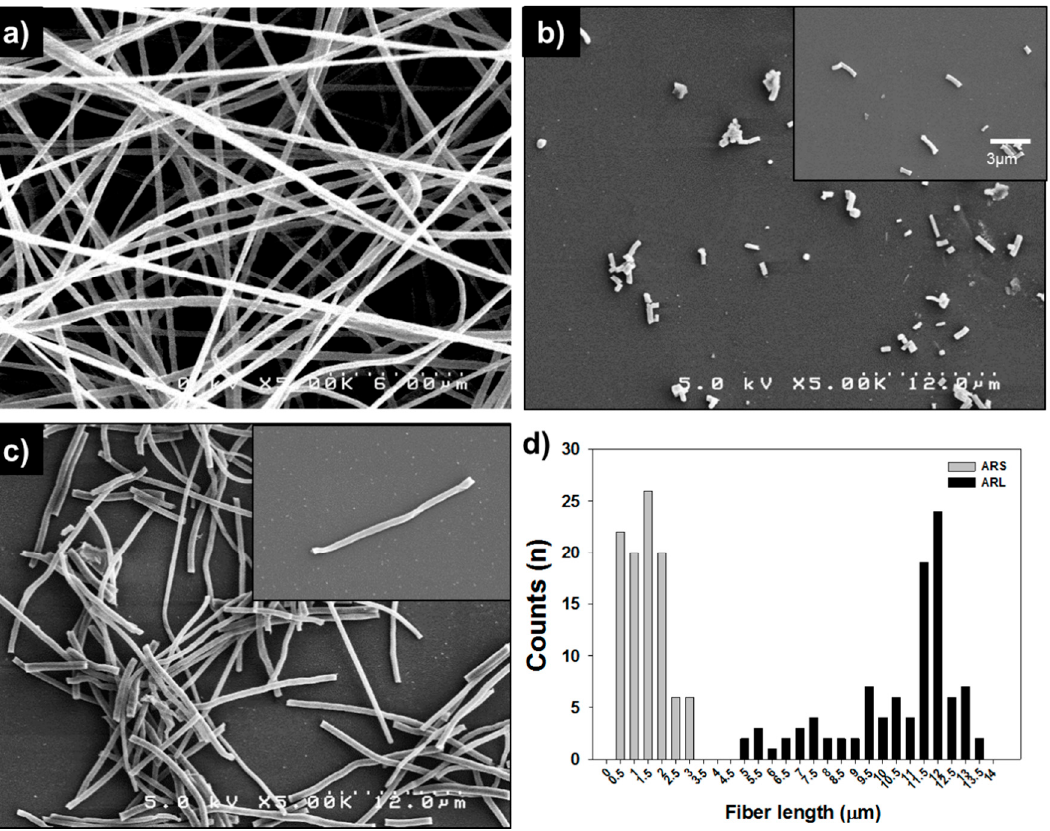
Figure 1. Scanning electron microscope (SEM) images of ( a ) electrospun PLA nanofibers before and ( b , c ) after aminolyzation to different aspect ratios nanocylinders; ( b ) aspect ratio small (ARS) and ( c ) aspect ratio large (ARL); and ( d ) distribution of NC length.